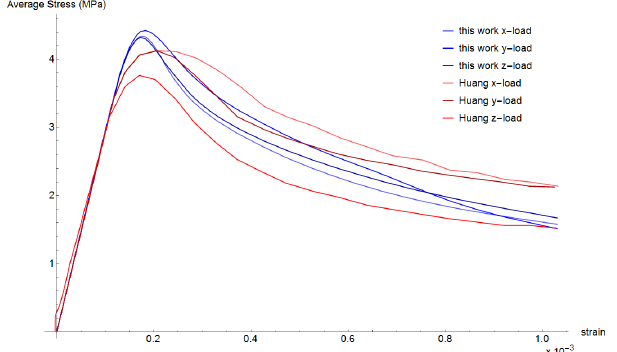
Figure 10. Simulated stress–strain curves for uniaxial tension test.